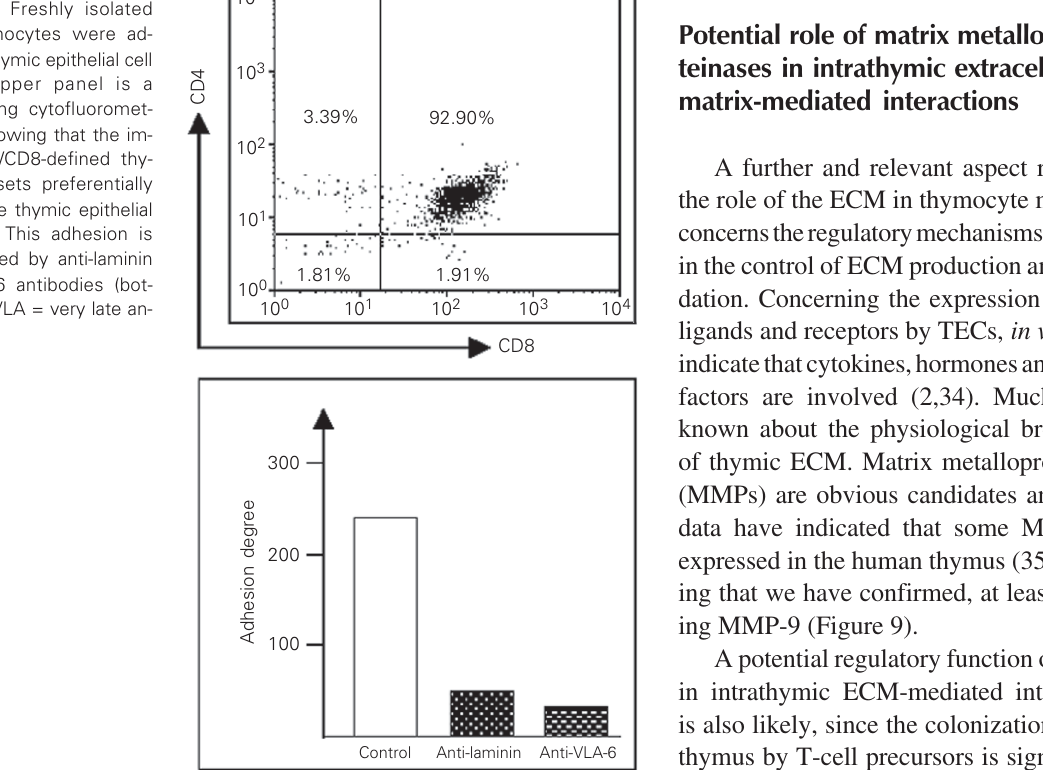
control.Figure 6. Disruption of laminin- VLA-6 interaction abolishes thy- mocyte adhesion to thymic epi- thelial cells. Freshly isolated mouse thymocytes were ad- hering to a thymic epithelial cell line. The upper panel is a double-labeling cytofluoromet- ric profile showing that the im- mature CD4/CD8-defined thy- mocyte subsets preferentially adhere to the thymic epithelial cell culture. This adhesion is largely blocked by anti-laminin or anti-VLA-6 antibodies (bot- tom panel). VLA = very late an-